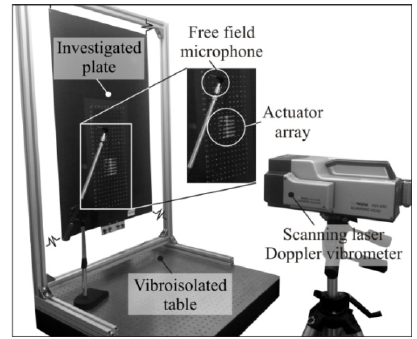
Figure 12. Experimental setup for the determination of propagation of induced mechanical and acoustical waves.